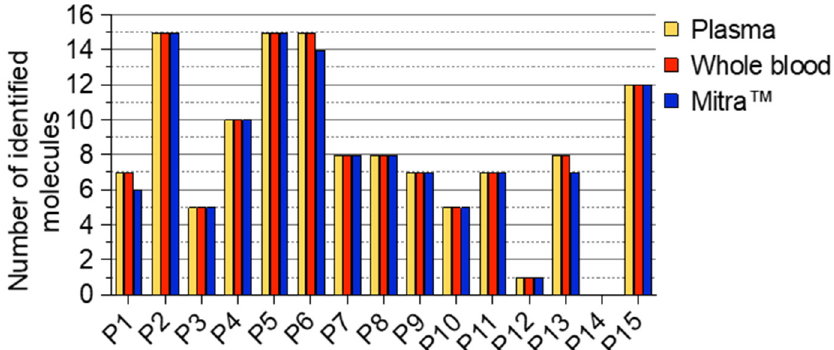
Figure 3. Comparison of the number of molecules identi fi ed in the di ff erent samples for the 15 pa- tients hospitalized in the toxicological critical care unit.